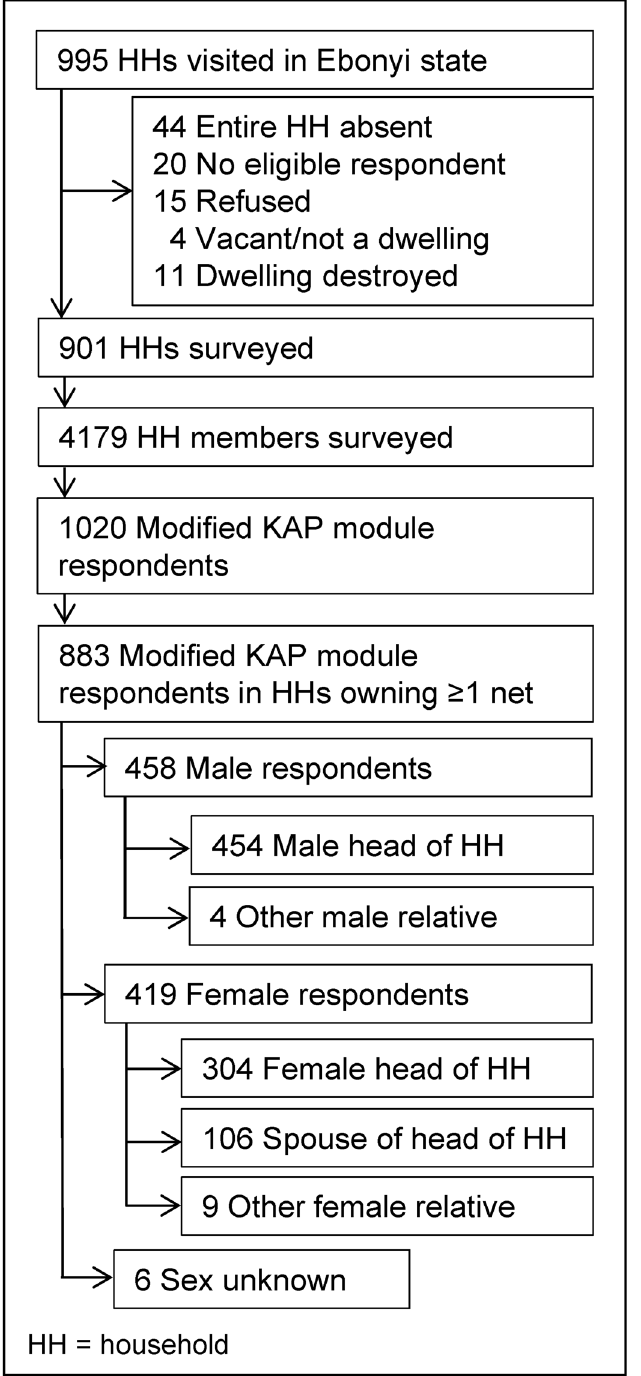
Fig 2. Survey sample. A depiction of the survey sample selection process.